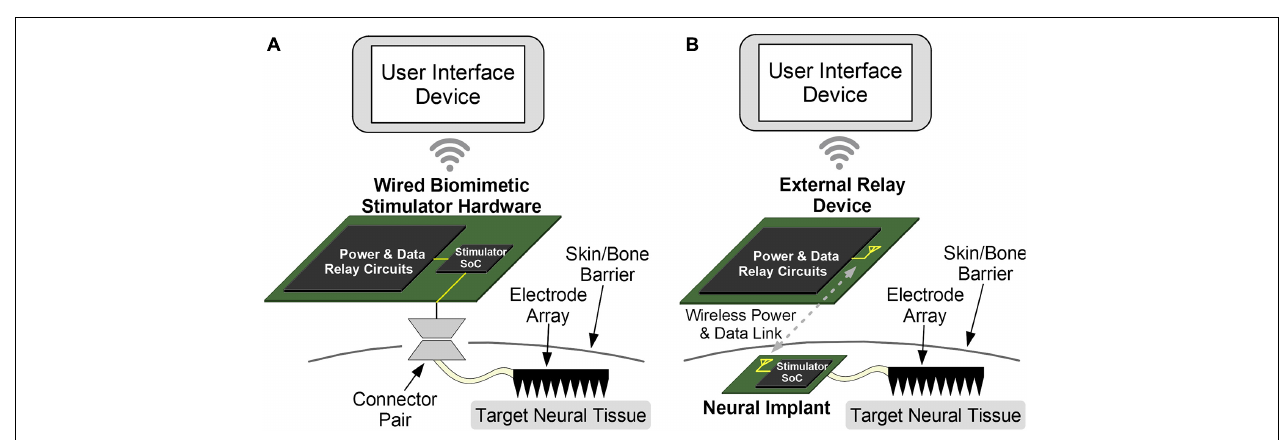
FIGURE 5 | The components of the proposed system can be arranged for wireless or wired implementations. (A) While the wired option is easier to implement and provides a stable and constant power, an external connector can disturb normal behavior and has increased risks of infection due to wire-through-skin. This option is best used for prototype testing and acute testing. (B) The wireless option is more complex due to challenging wireless data and power links. But the intact skin reduces chances of infection, and chronic experiments can be conducted with normally behaving animals. The wireless approach is further translatable for chronic human